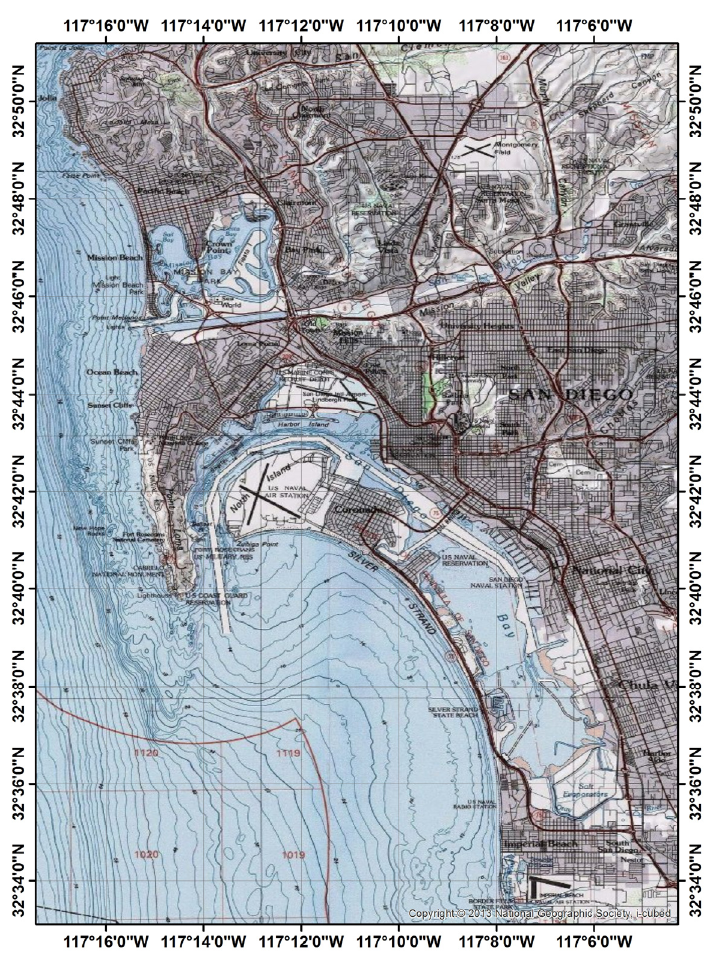
Figure 4. Map of San Diego Bay, showing the state of the harbor today with locations that are referenced frequently throughout the